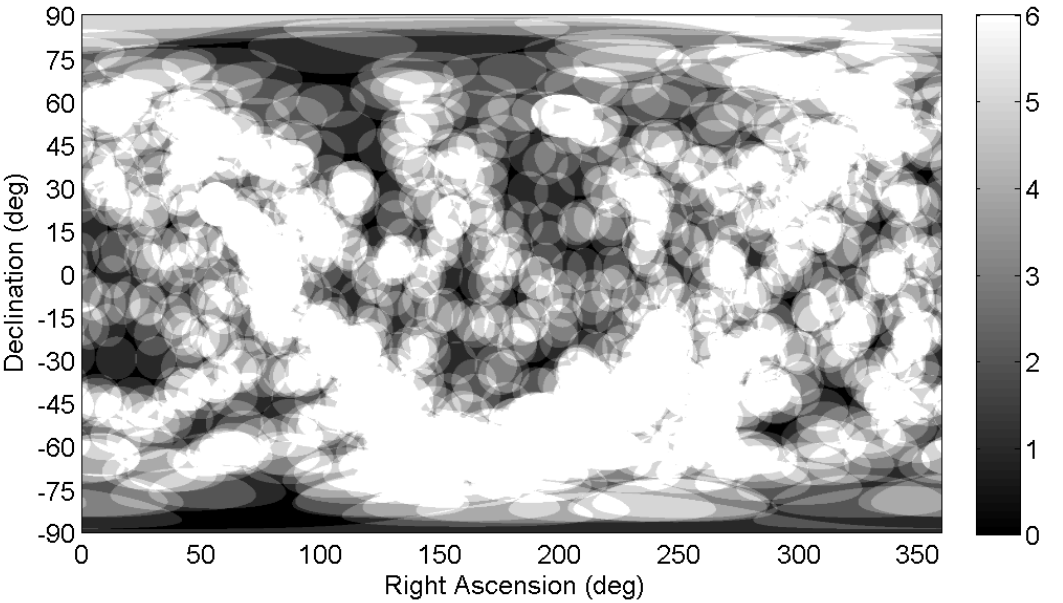
Figure 14. Spatial dynamic availability map of the ST-16 star tracker (1 ◦ /s). Note: the color axis is flipped with respect to Figure 4 to increase the visibility of star-sparse